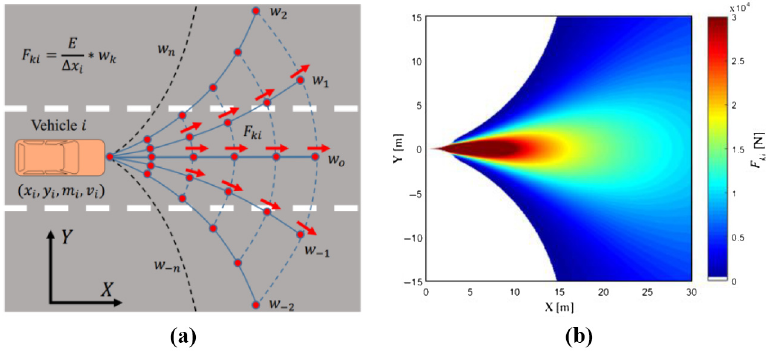
Figure 10 The distribution of equivalent force in traf fi c safety fi